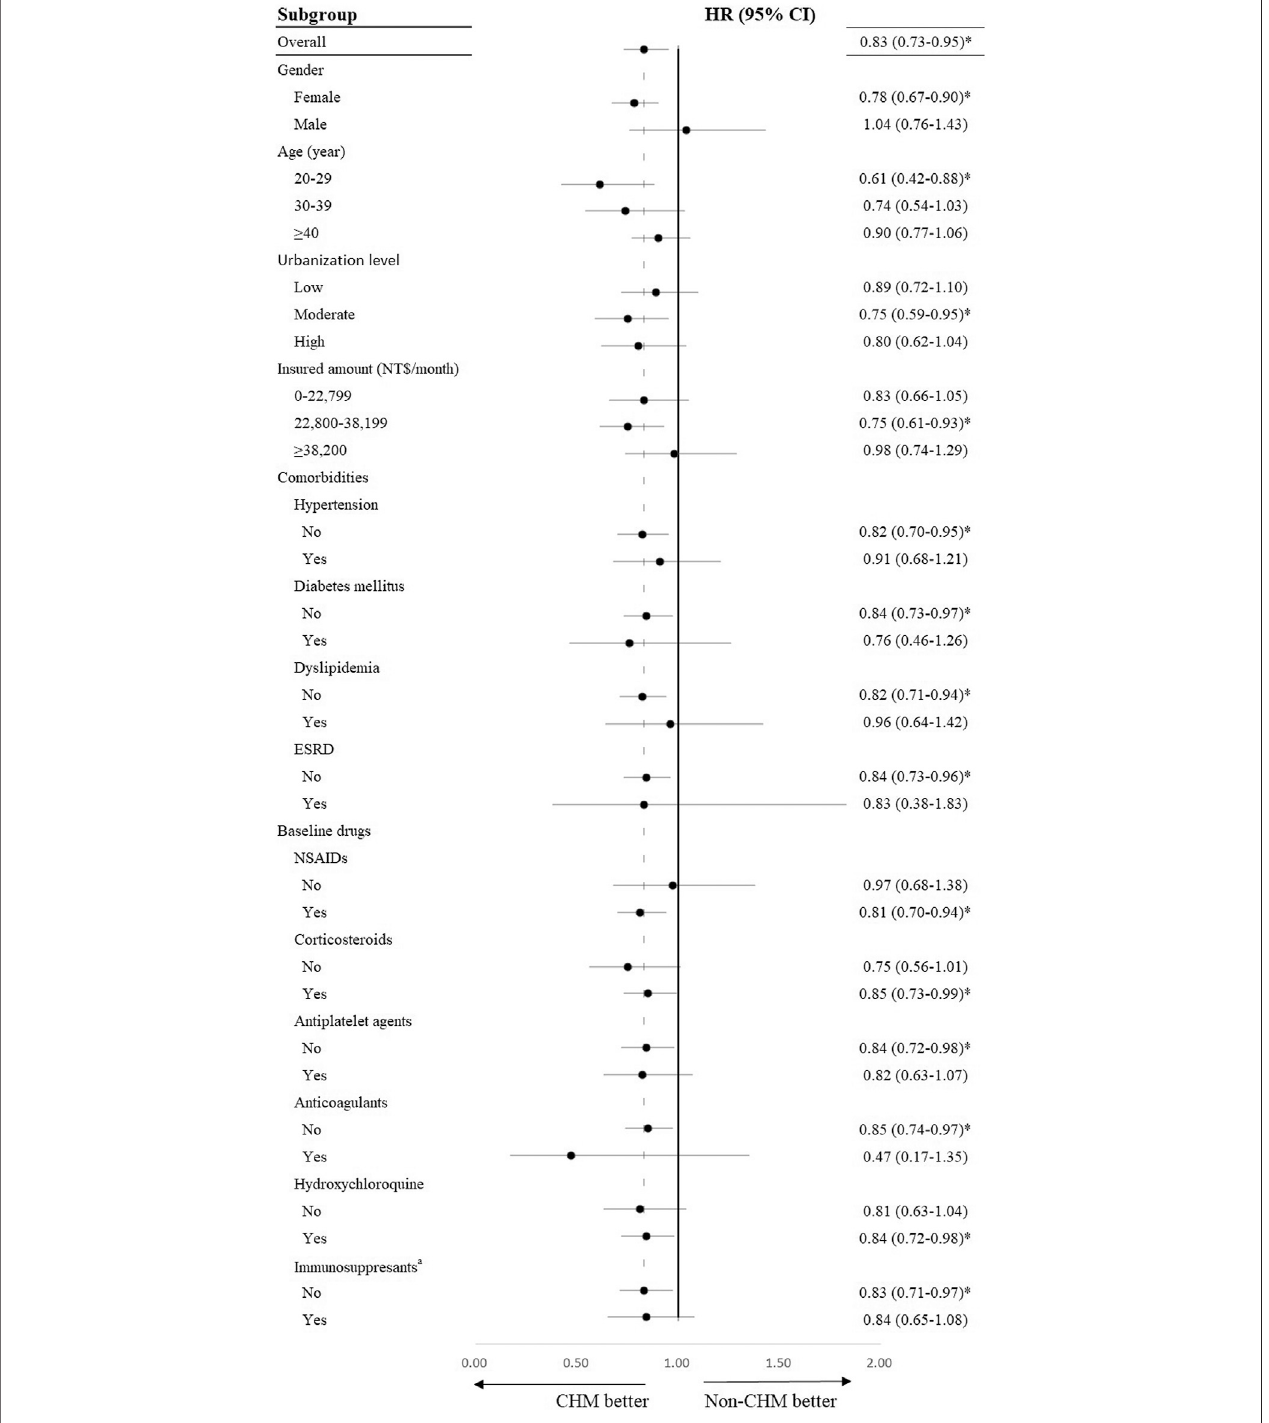
FIGURE 3 | Strati fi cation analysis of hazard ratios of cardiovascular disease among systemic lupus erythematosus patients treated with Chinese herbal medicines (in comparison with systemic lupus erythematosus patients treated without Chinese herbal medicine). Adjusted for age, gender, insured amount, urbanization level, comorbidities,andbaselinedrugs.HR,hazardratio;CI:con fi denceinterval;ESRD,end-stagerenaldisease;NSAID,nonsteroidalanti-in fl ammatorydrug;CHM,Chinese herbal medicine. a Azathioprine, methotrexate, le fl unomide, mycophenolic acid, cyclosporine, and cyclophosphamide. * p -value < 0.05.